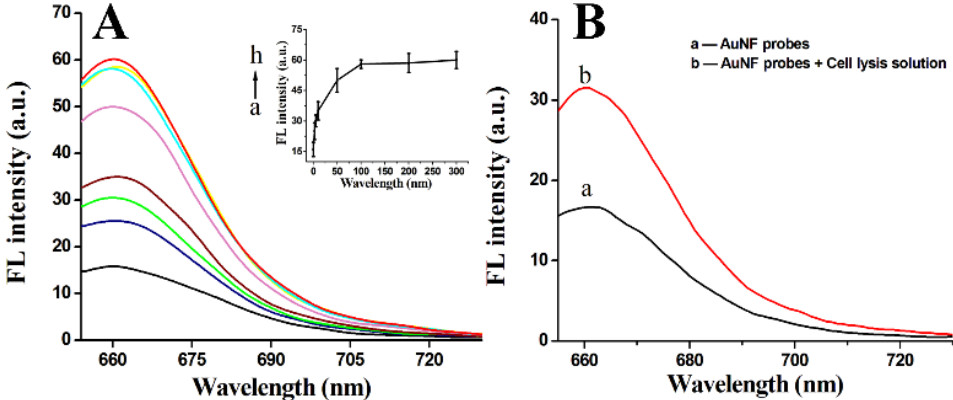
Figure 3. Fluorescence spectra of AuNF probes incubated with different concentrations of Target- DNA (0, 2.5, 5, 10, 50, 100, 200, and 300 nM) ( A ) or HeLa cell lysis solution ( B ).